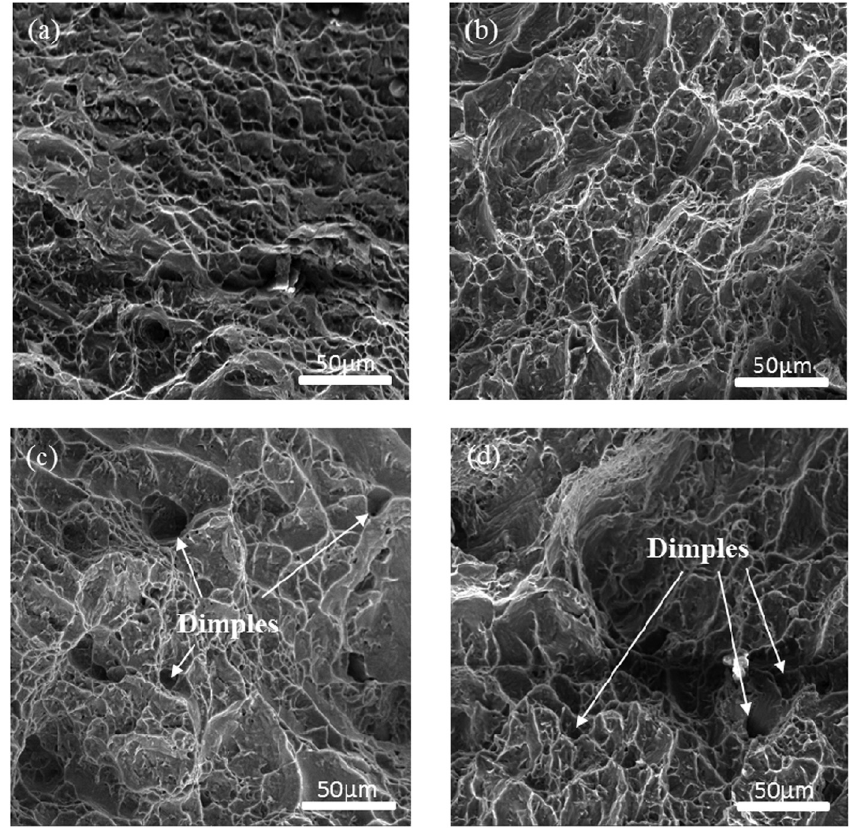
Figure 8: The scanning electron micrographs of the fracture morphologies for the tensile specimens deformed at di ff erent strain rates: ( a ) 0.01 s − 1 , ( b ) 0.1 s − 1 , ( c ) 1 s − 1 , and ( d ) 10 s − 1